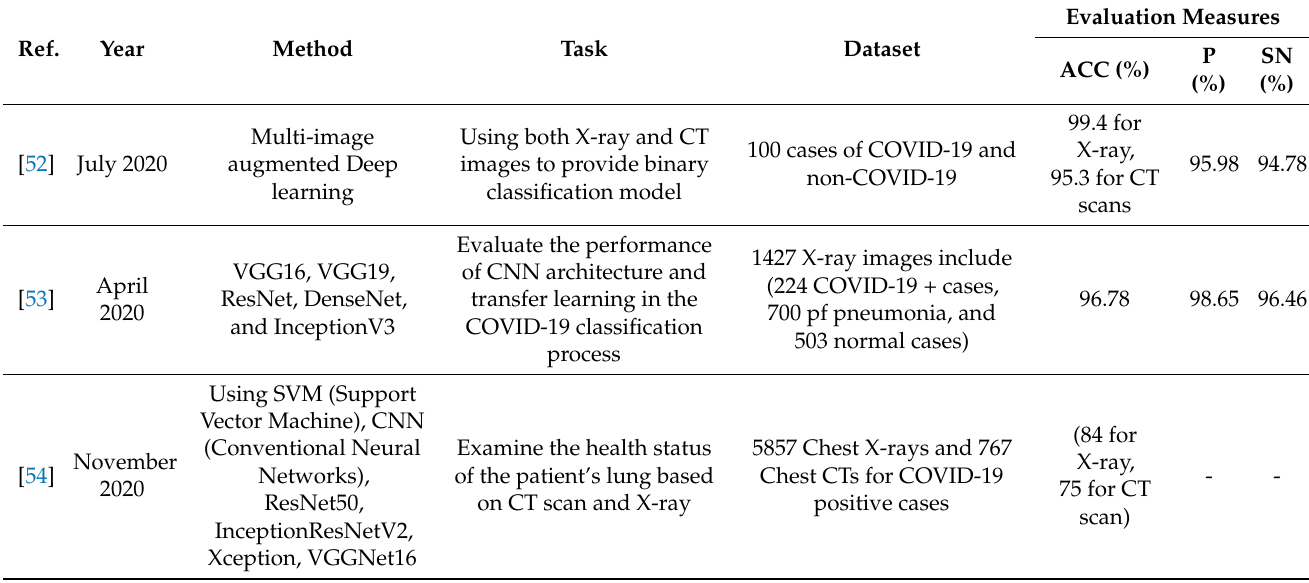
Table 3. Comparison between AI diagnosis algorithms based on X-ray for COVID-19 patients.